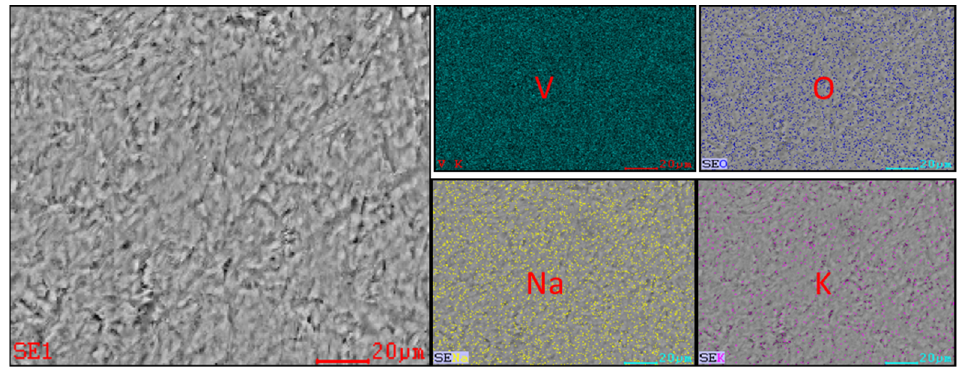
Figure 3. Morphology analysis and interface element content analysis of vanadium pentoxide.